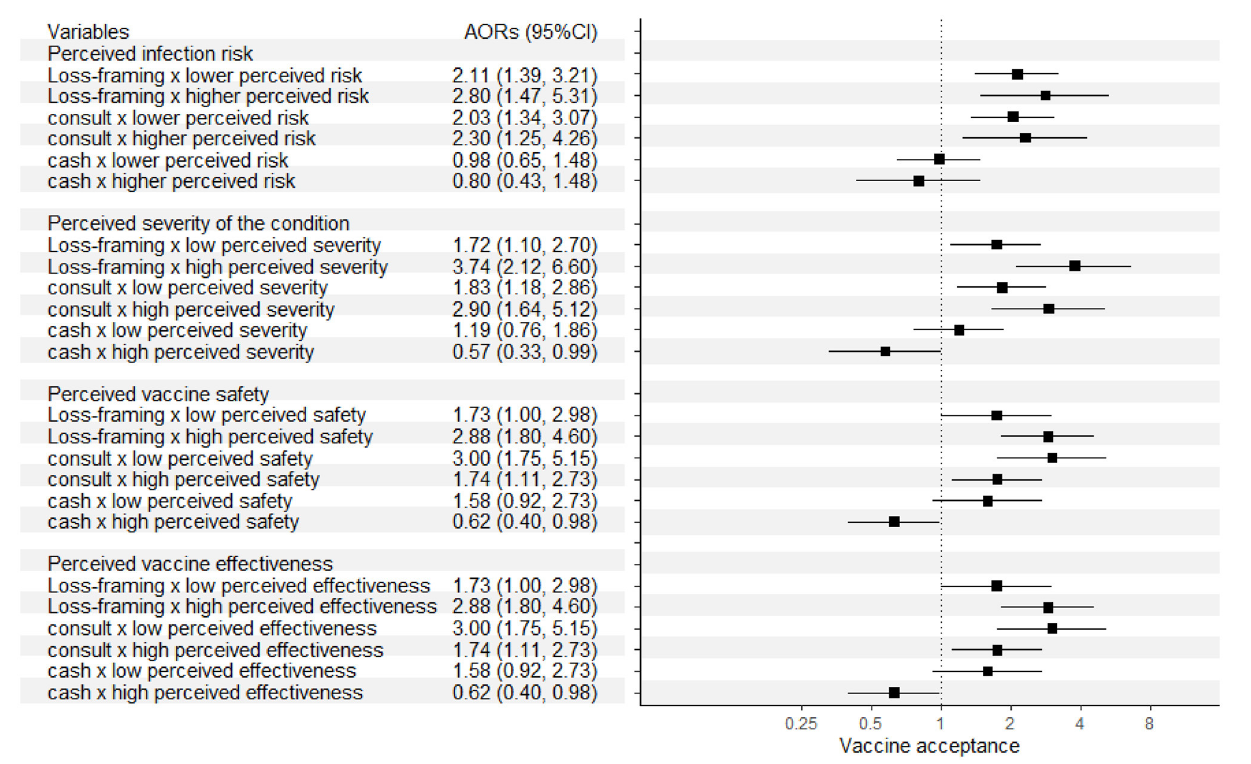
FIGURE3 Effects of the three strategies according to different perceptions of the participants who received at least one dose of